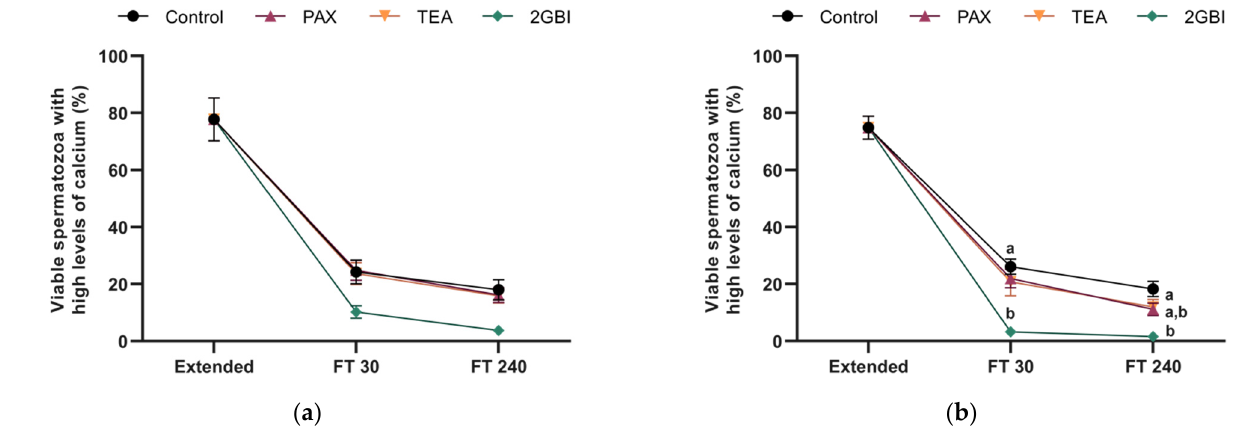
Figure 6. Percentages of viable spermatozoa with high levels of intracellular calcium in extended samples and frozen—30 min and 240 min post-thaw. In Experiment 1 ( n = 8), TEA, PAX, and 2-GBI blockers were added to LEY medium at 15 °C ( a ), whereas in Experiment 2 ( n = 9), they were added to LEYGO medium at 5 °C ( b ). Different superscripts indicate significant differences ( P < 0.05) between samples within the same time point. Results are given as mean ± SEM.